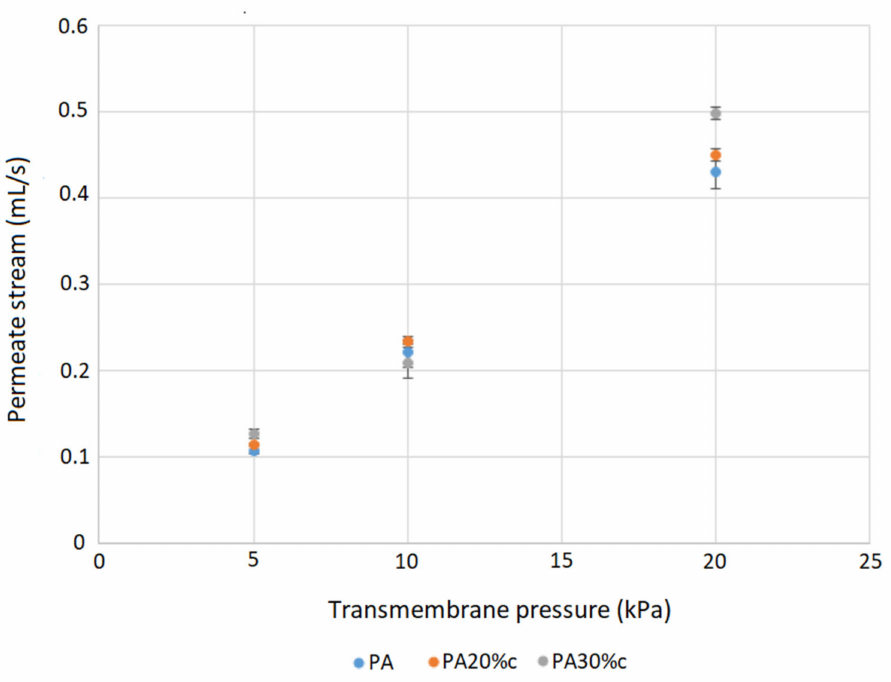
Figure 10. Permeate stream through a neat polyamide membrane (PA) and membranes with 20% (PA20%c) and 30% (PA30%c)